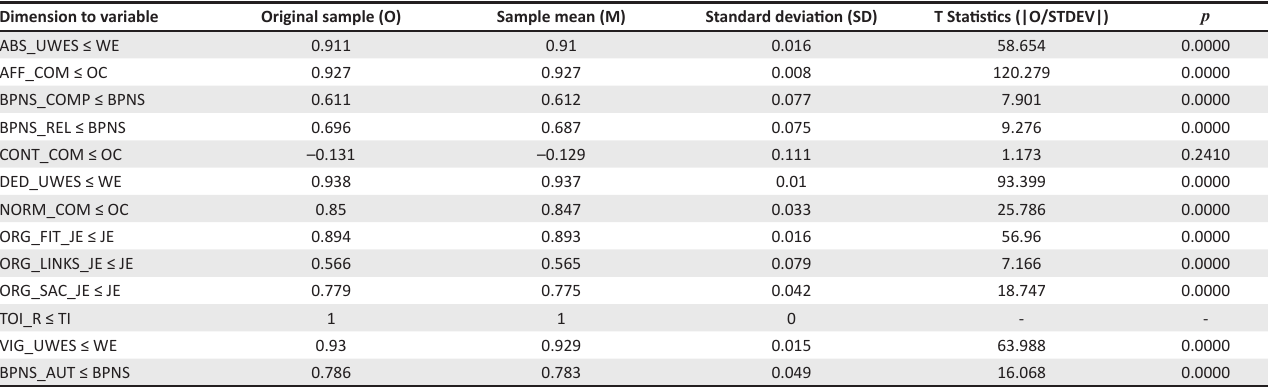
TABLE 5: Loadings per dimension towards each variable (Round 1). Dimension to variable